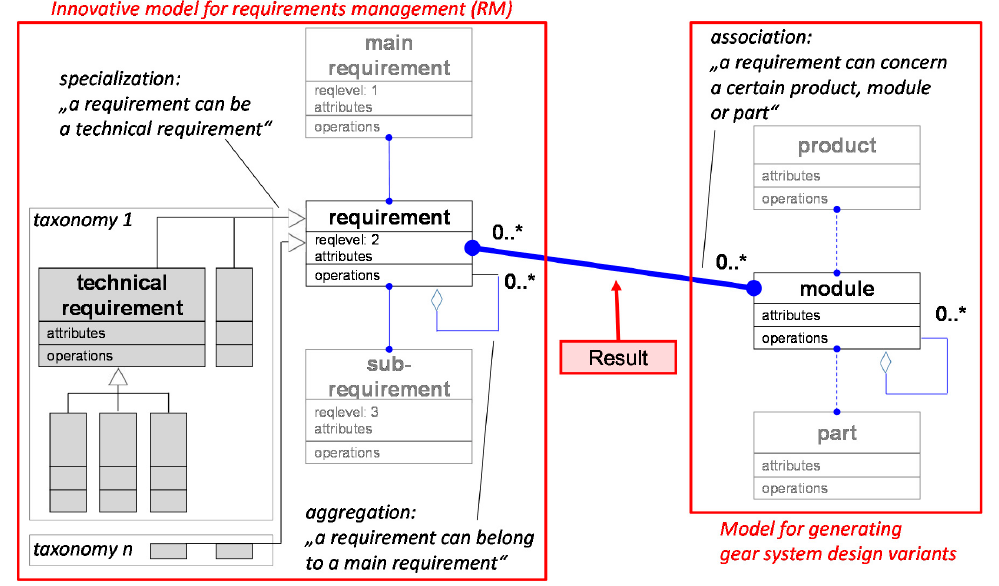
Figure 15. General approach of model-based requirements management.